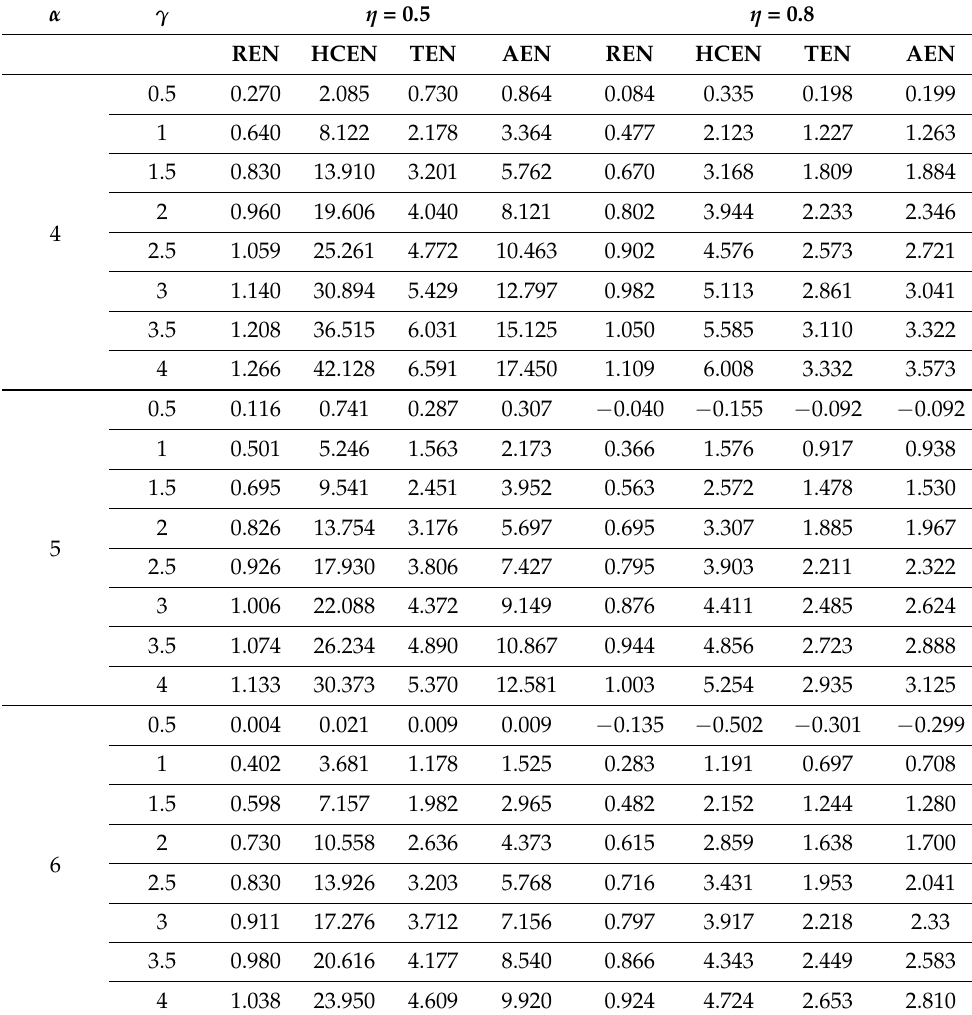
Table 1. Analysis of the REN, HCEN, TEN, and AEN for the HL-INH distribution at λ = 1.5 and η = 0.5 and 0.8.